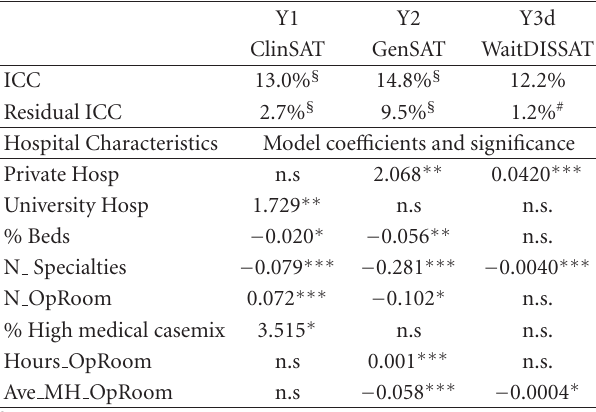
Table 2: ICC and significant hospital